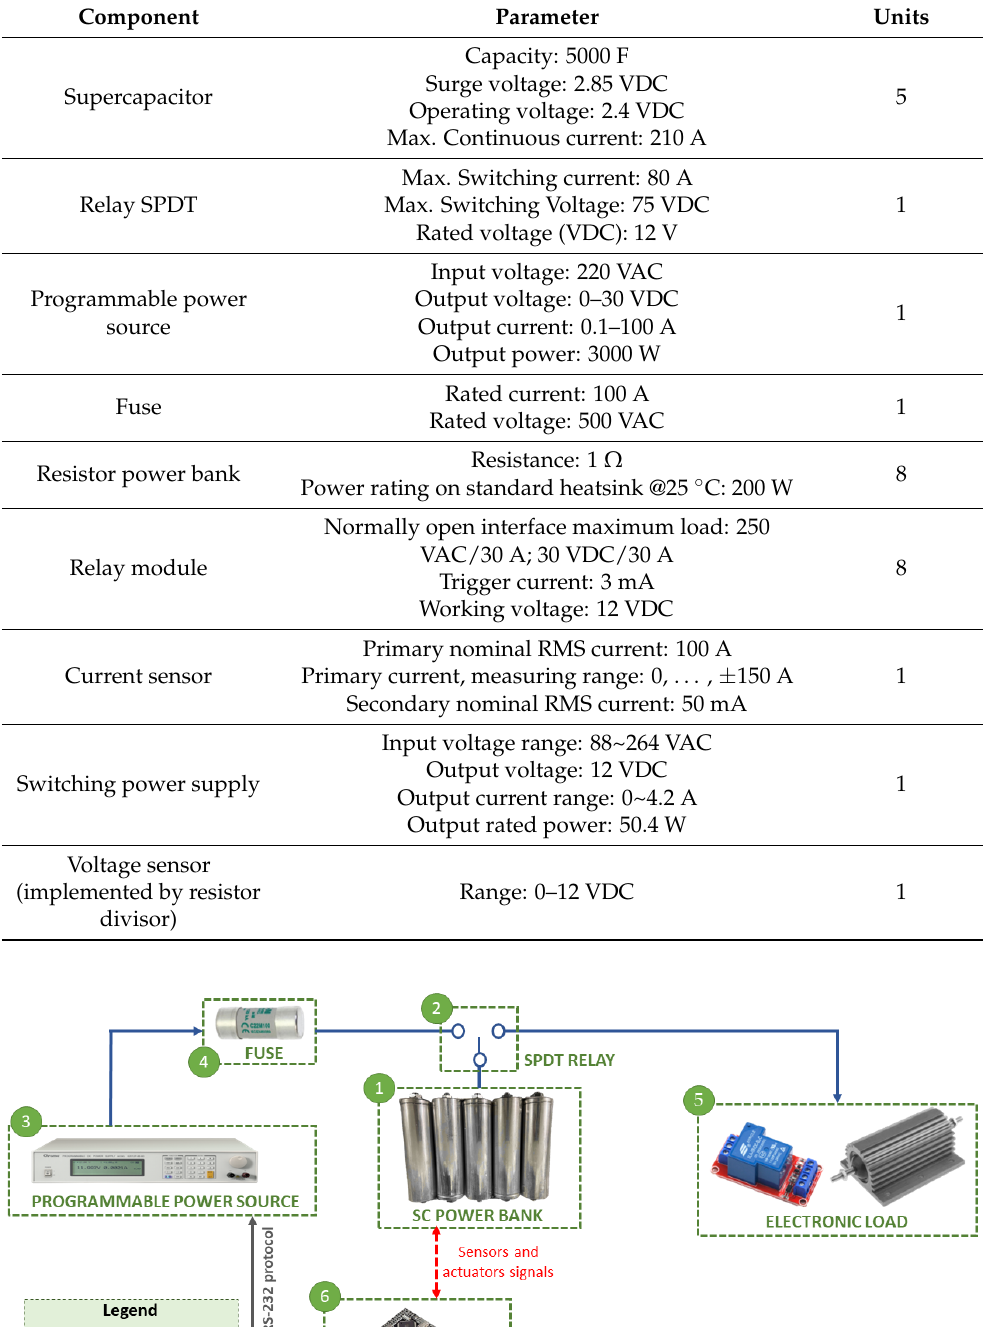
Table 2. Supercapacitor power bank. Component specifications.